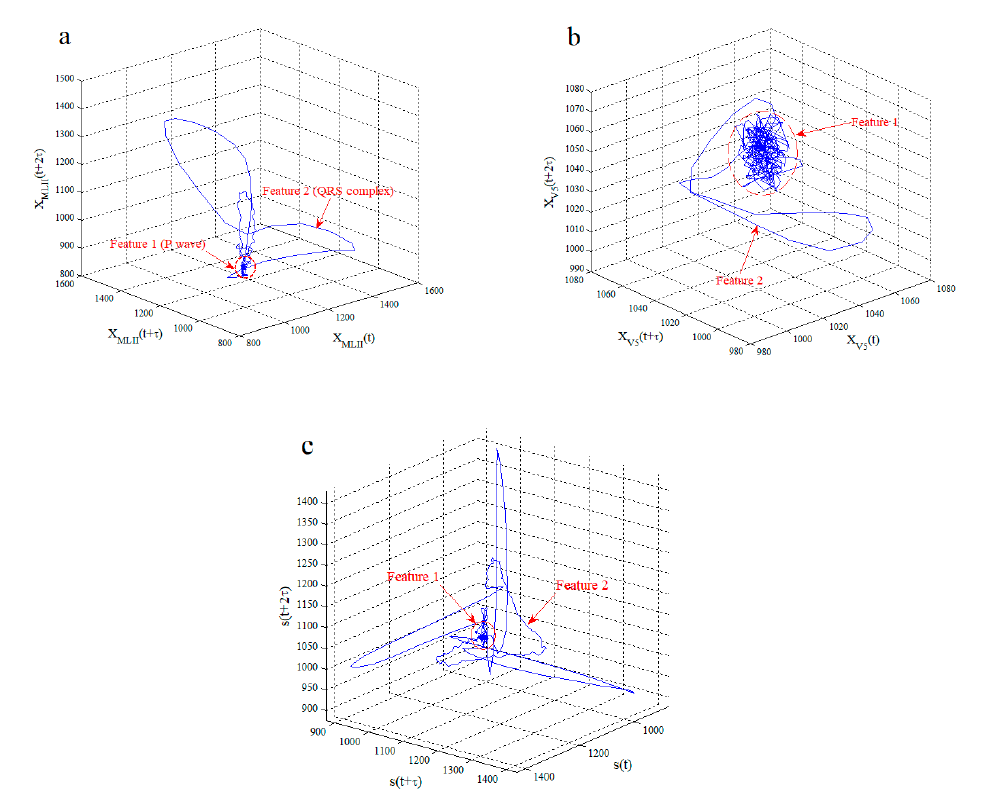
Figure 7. Reconstructed phase trajectories of ECG signals (No.106). ( a ) and ( b ) are reconstructed phase trajectories of lead MLII and lead V5 , respectively. ( c ) is reconstructed phase trajectory of final fused result via NDFA.